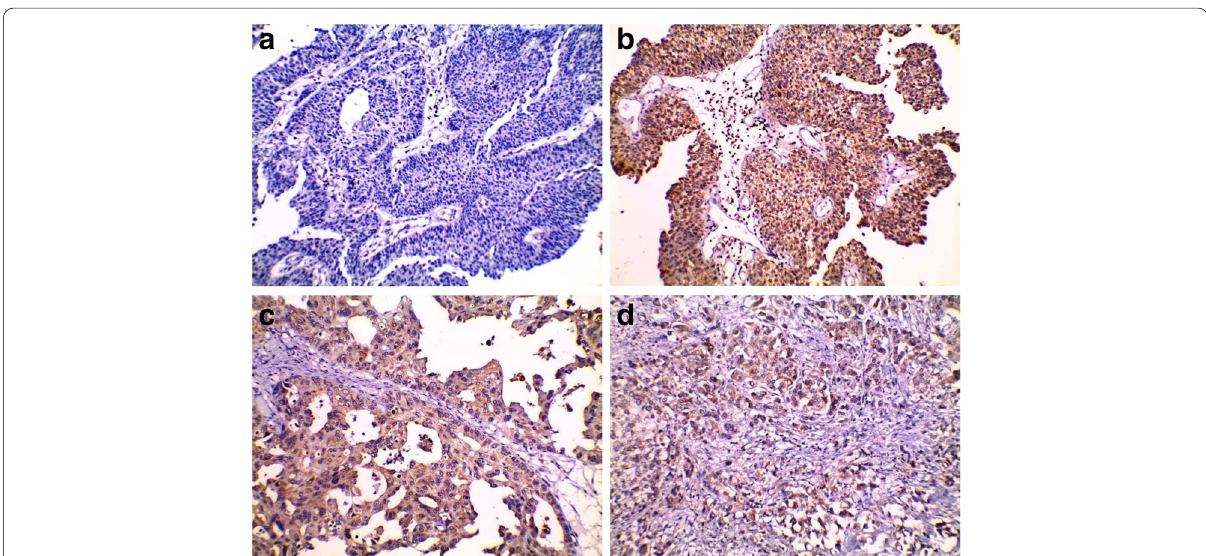
Fig. 1 Immunohistochemical expression of GLUT 4 ( 200) shows: a low GLUT4 expression in low‑grade pT a urothelial carcinoma (UC), b high × GLUT4 expression in low‑grade pT a UC, c high GLUT4 expression in high‑grade pT 1 UC, and d high GLUT4 expression in high‑grade pT 2